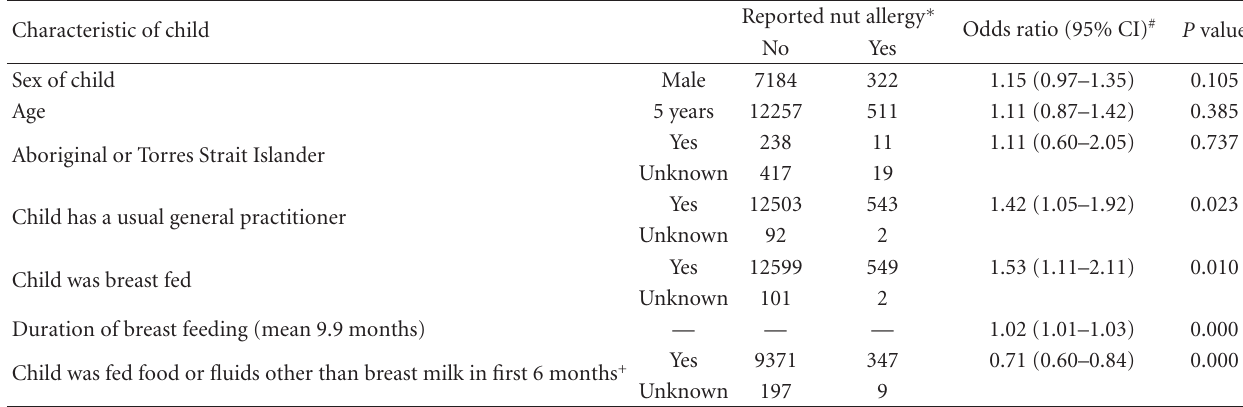
Table 2: Odds ratios for reported nut allergy and characteristics of kindergarten children in the Health Check Questionnaire 2006–2009. Characteristic of